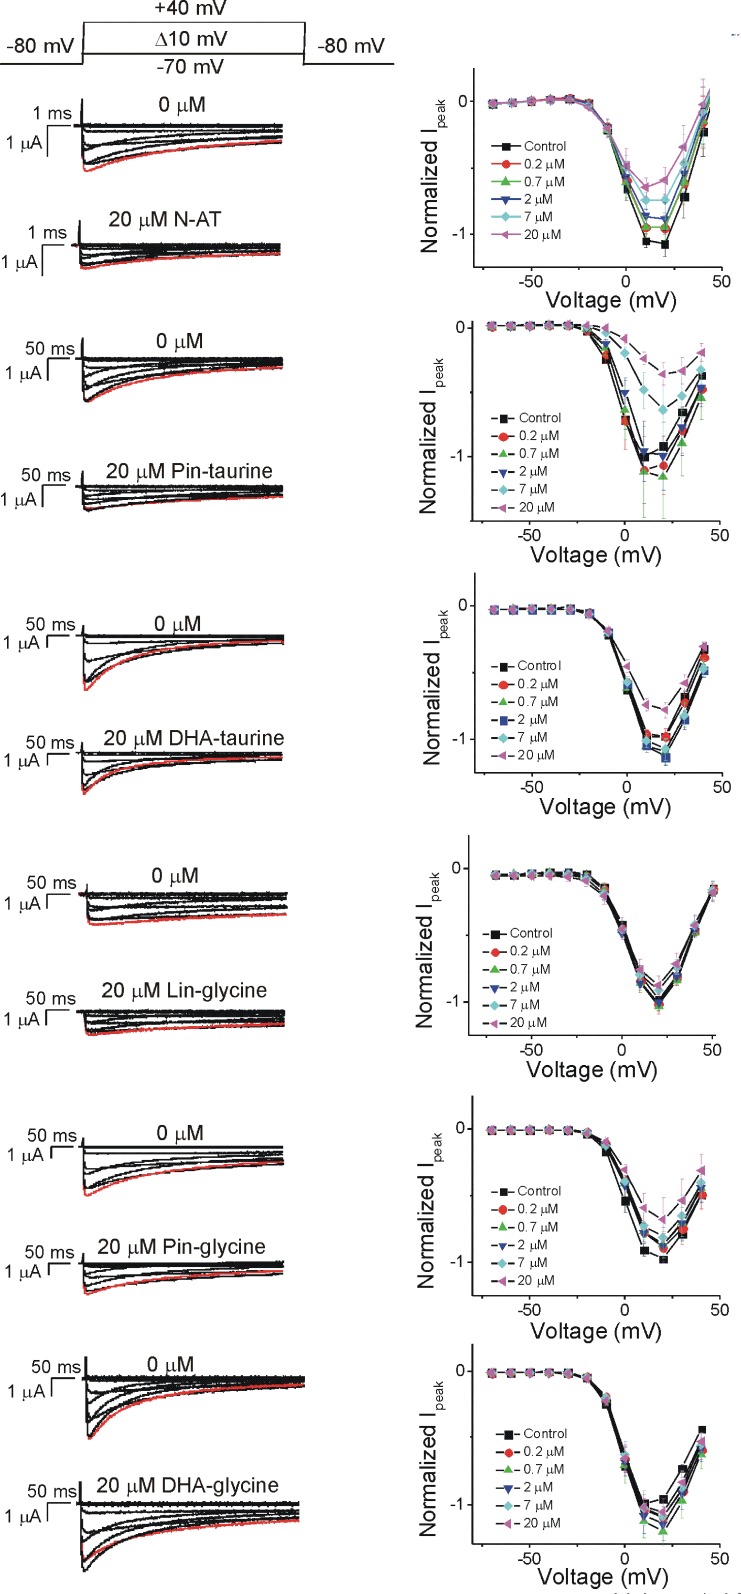
Raw current traces for PUFA analogues on Cav1.2/β3/α2δ.Cav1.2/β3/α2δ raw current traces in control (0 μM) (top trace for each PUFA analogue) and 20 μM (bottom trace for each PUFA analogue), followed by current-voltage (I–V) relationship (right) of voltage dependent activation for each PUFA analogue tested. Voltage protocol (top) overlaps with current traces to illustrate time points during the voltage steps. Red traces represent the voltage step that elicits peak current.